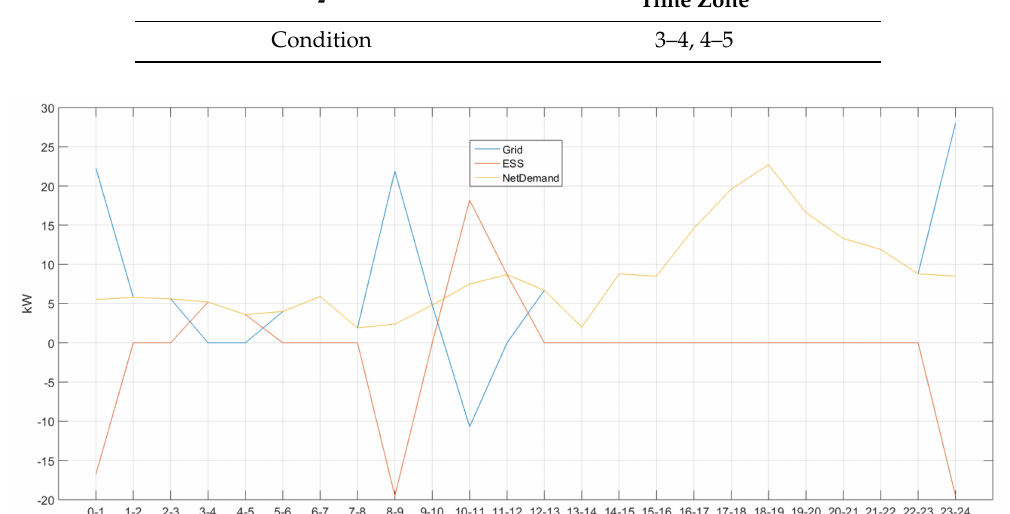
Figure 7. Simulation result when the conditional equation for net zero operation was